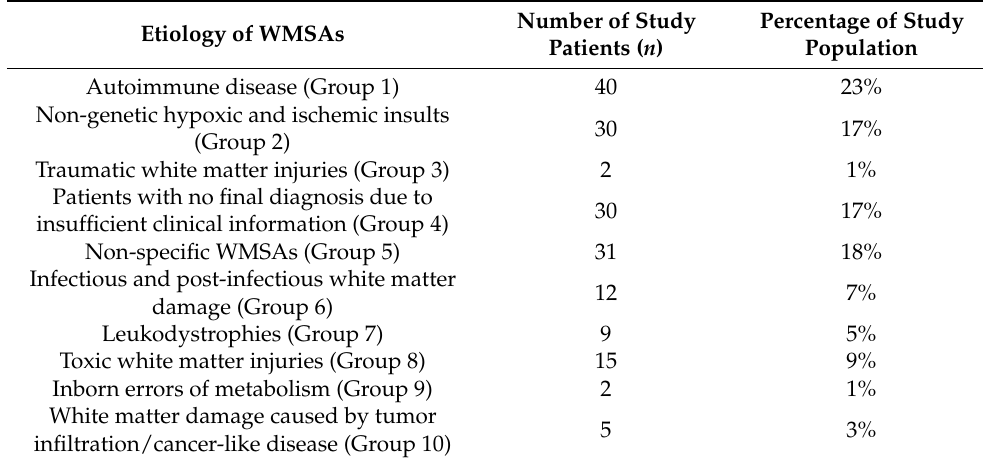
Table 2. Etiology-based classification of WMSAs encountered in the study population. Number of patients and percentage of study population. Percentage rounded to the nearest whole number.